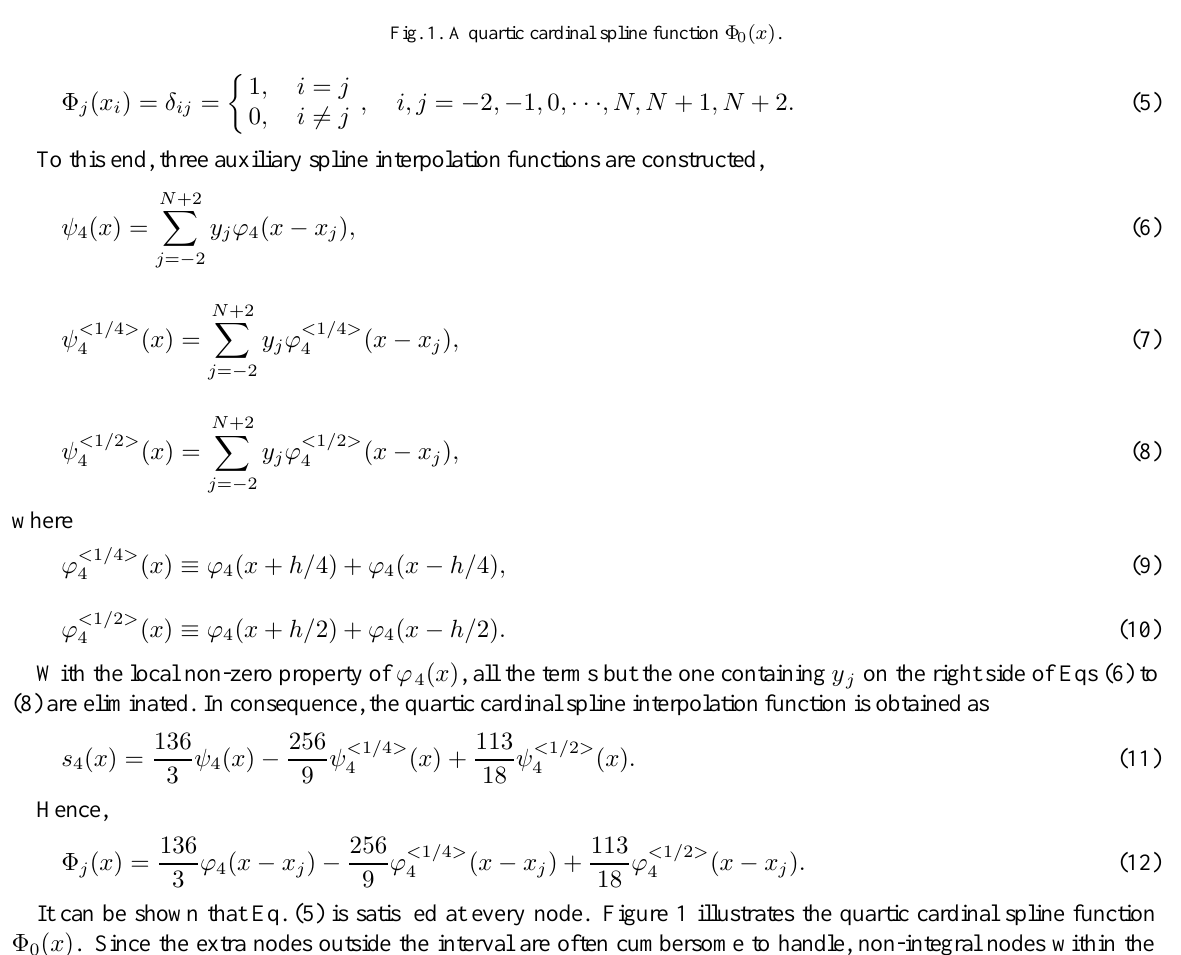
Fig. 1. A quartic cardinal spline function Φ 0 ( x )